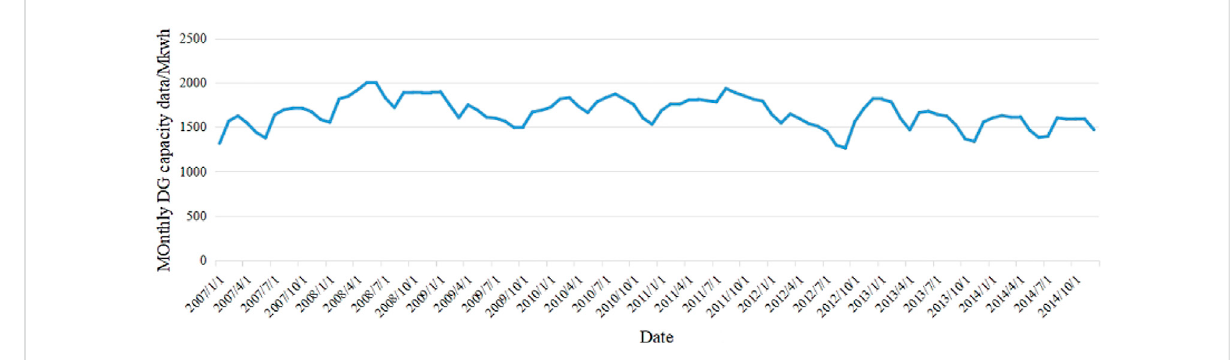
FIGURE 6 Monthly DG capacity data curve.